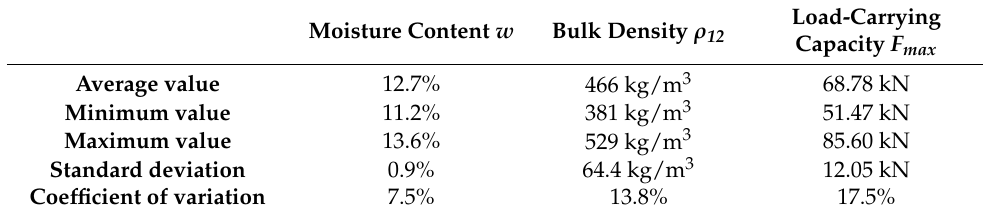
Figure 9. Load-deformation curves of K2 specimens. Table 2. Results of the experimental testing of K1 Table 3. Results of the experimental testing of K2 specimens.